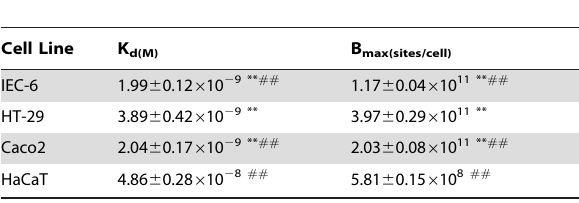
Table 1. Receptor-ligand binding affinities and maximum numbers of binding sites for ITF on epithelial and epidermal cells(n